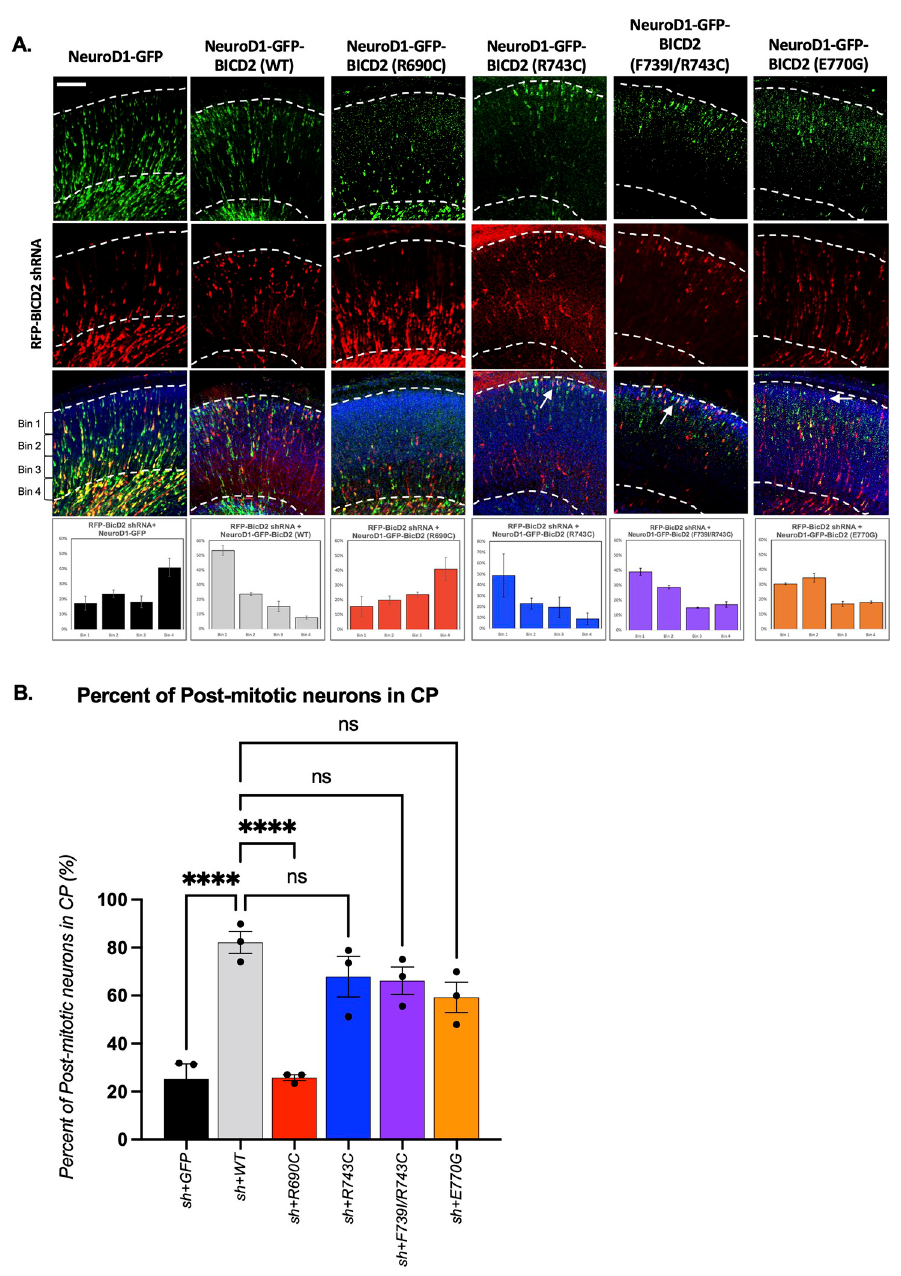
Fig 5. BICD2 R690C mutation causes a specific neuronal migration defect. E16 rat brain was in utero co- electroporated with GFP tagged wildtype/mutant BICD2 cDNAs under control of the NeuroD1 promoter for neuron specific expression and an RFP-BICD2 shRNA [5] to perform rescue experiments. E20 brain slices were imaged and the distribution of co-electroporated postmitotic neurons were analyzed. Representative cortical plate (CP) images are shown. (A) Top panels show post-mitotic neurons electroporated with wild type or mutant constructs. The middle panels show RFP-BICD2 shRNA expressing cells followed by merged images of the GFP and RFP channels. To quantify the postmitotic neuronal distribution in CP, distances from the pial surface (the upper white dashed line) to the cell were measured and the histograms are shown in the bottom panels. The relative bin size was calculated by assessing the cortical plate thickness for each brain slice, and then divided into four regions (Bin1, 2, 3, and 4). Scale bar = 100 μ m. (B) Mean percent of the postmitotic neurons in the cortical plate. Error bars show the S.E.M from at least 3 different brains. Each black dot represents one brain. One-way ANOVA with Dunnette’s test was performed for statistical analysis. (ns = not significant; ���� p < 0.0001).